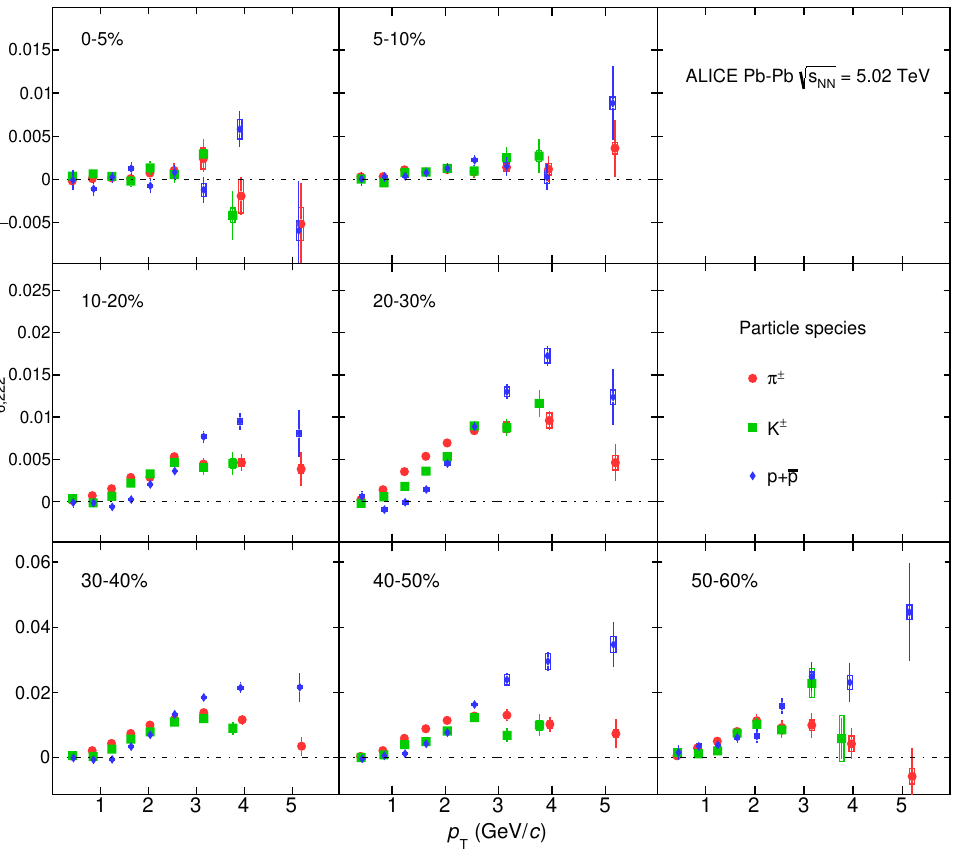
Figure 9 . The p T -di(cid:11)erential v 6 ; 222 for di(cid:11)erent particle species grouped into di(cid:11)erent centrality p intervals of Pb-Pb collisions at s NN = 5 : 02 TeV. Statistical and systematic uncertainties are shown as bars and boxes,